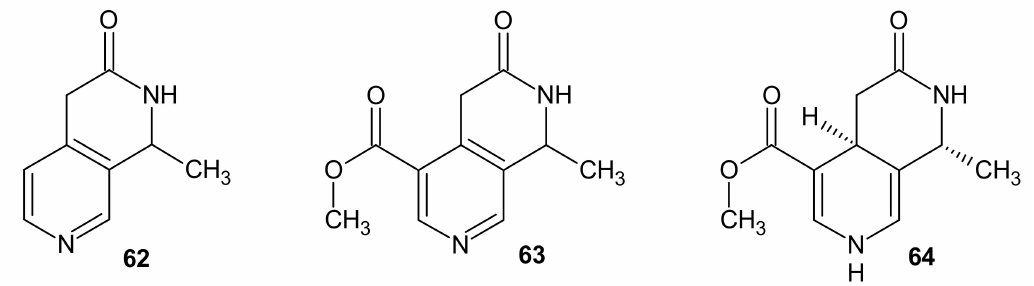
Figure 20. Jasminine 62 , jasminidine 63, and dihydrojasminine 64 .